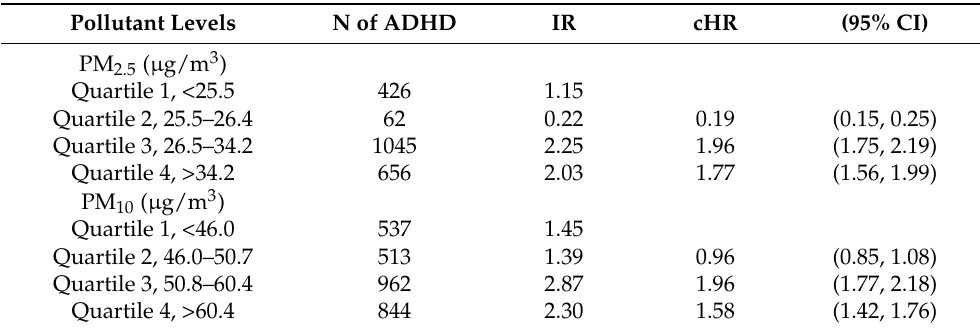
Table 2. The risk of ADHD in patients exposed to various air pollutants stratified by quartile of daily average concentration using the Cox proportional hazard